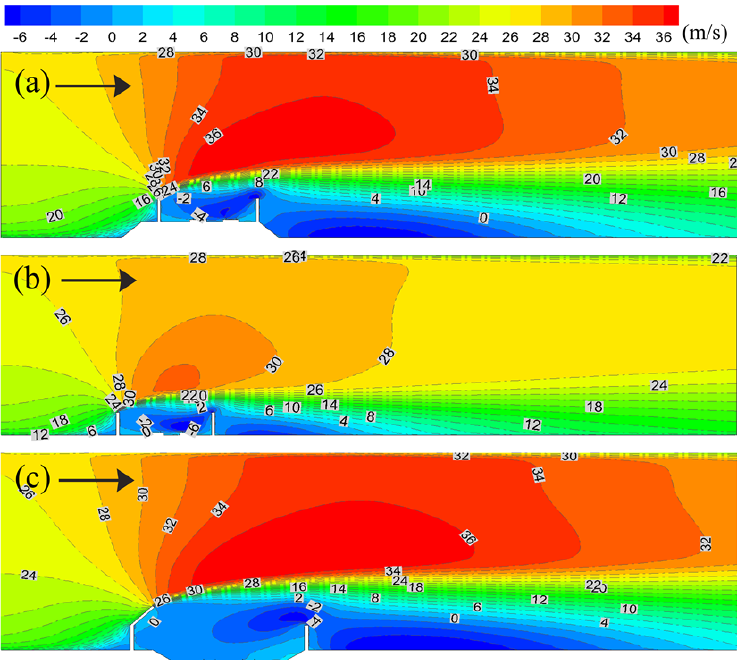
Figure 14. Sand sedimentation prevention measures along wind-break walls: ( a ) convex subgrade, ( b ) flat subgrade, and ( c ) concave